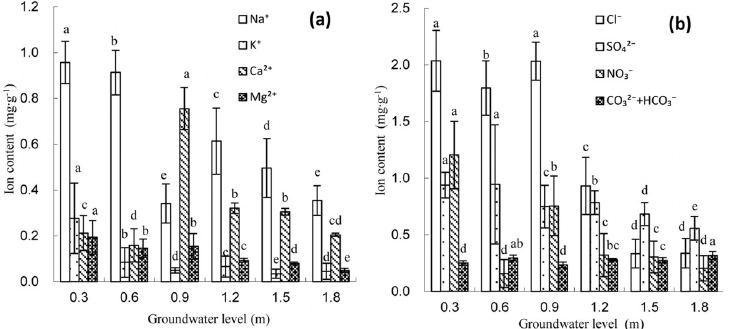
Fig 3. Content of salt ion under different groundwater level in soil columns. (a) Salt cation; (b) Salt anion.